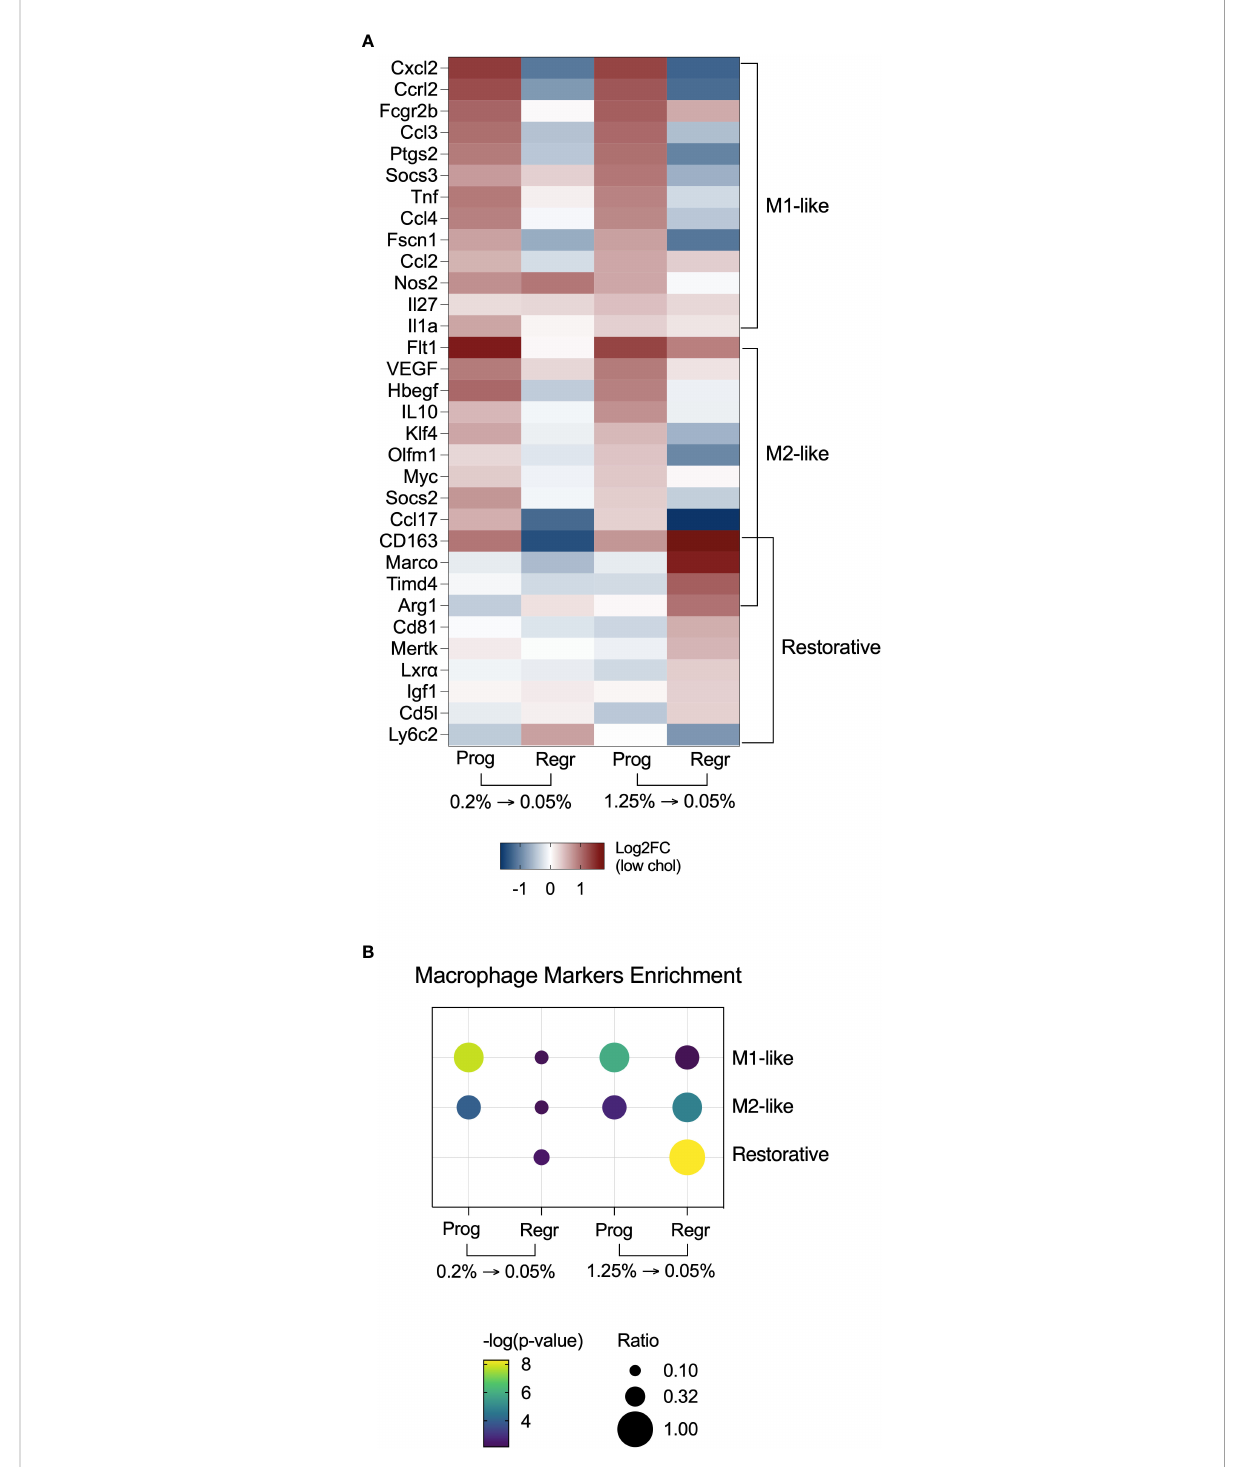
FIGURE 6 Hepatic macrophages from mice fed with high cholesterol FPC diet shift polarization towards a restorative phenotype after cholesterol reduction. (A) Heatmap with macrophage polarization markers shows enrichment of M1 and M2-like polarization markers during the progression of the FPC diet, and enrichment of restorative macrophages markers during the regression phase in the high cholesterol group. (B) Fisher ’ s exact test con fi rmed the enrichment of polarization markers in hepatic macrophages during the different phases of the dietary intervention. Prog, Progression phase; Regr, Regression phase; Log2FC, log2-foldchange based on low cholesterol age-matched